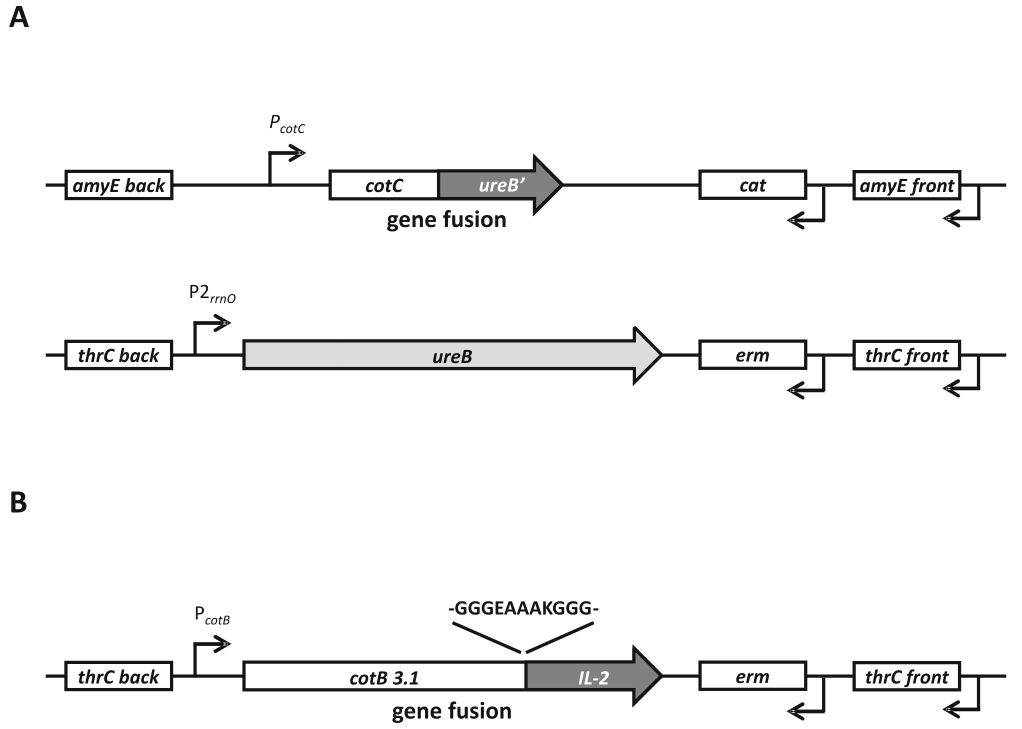
Figure 1. Schematic representation of the three gene fusions constructed. Panel A – gene fusions present in the chromosome of BKH108 strain, Panel B – gene fusion present in the chromosome of BKH121 strain.